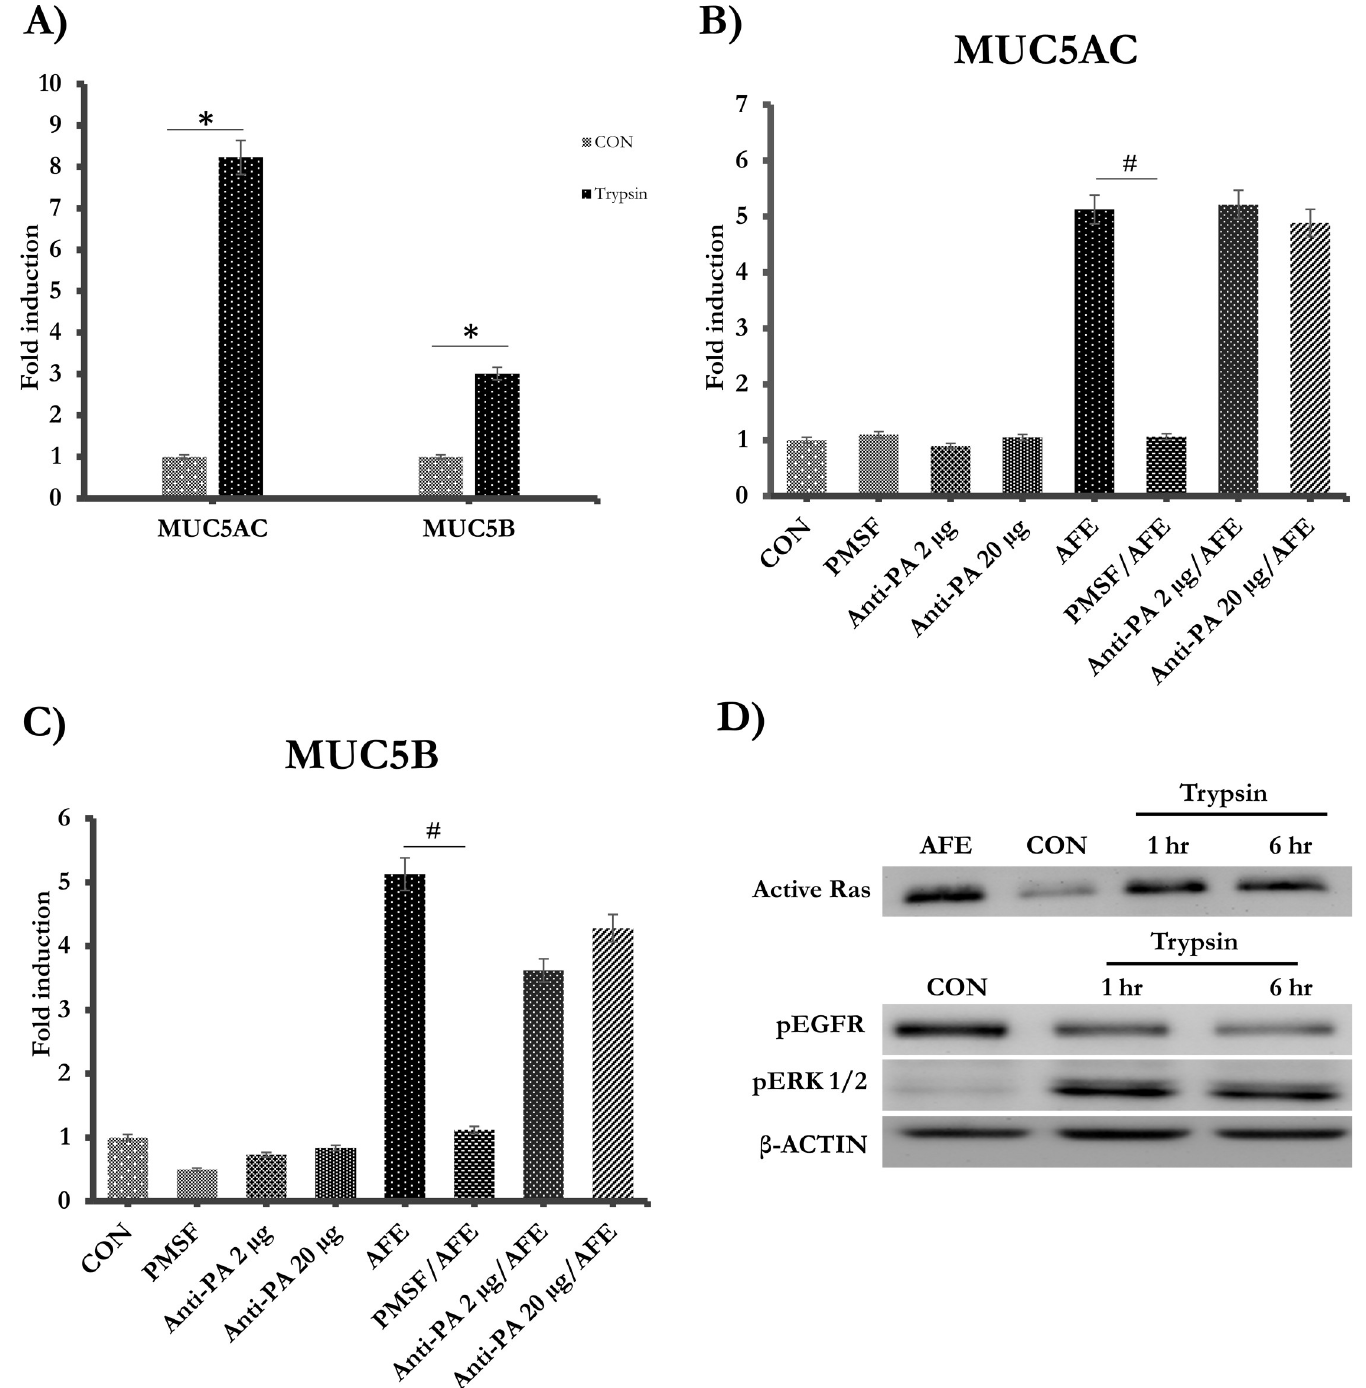
Fig 3. Fungal protease activity was required for mucin expressions. ( A) The cells were treated with 100 nM trypsin for 6 hrs. MUC5AC and MUC5B were quantified by Real-Time PCR. (B-C) The cells were pre-incubated with two different doses (2 μ g/ml and 20 μ g/ml) of PAR2 antibody and then stimulated with AFE for 6 hrs. MUC5AC and MUC5B mRNA levels were measured. (D) The cells were treated 100 nM trypsin for 1 hr, 6 hrs and then probed with anti-Ras, pEGFR, pERK1/2 and β - ACTIN antibody. #, � P < 0.05.